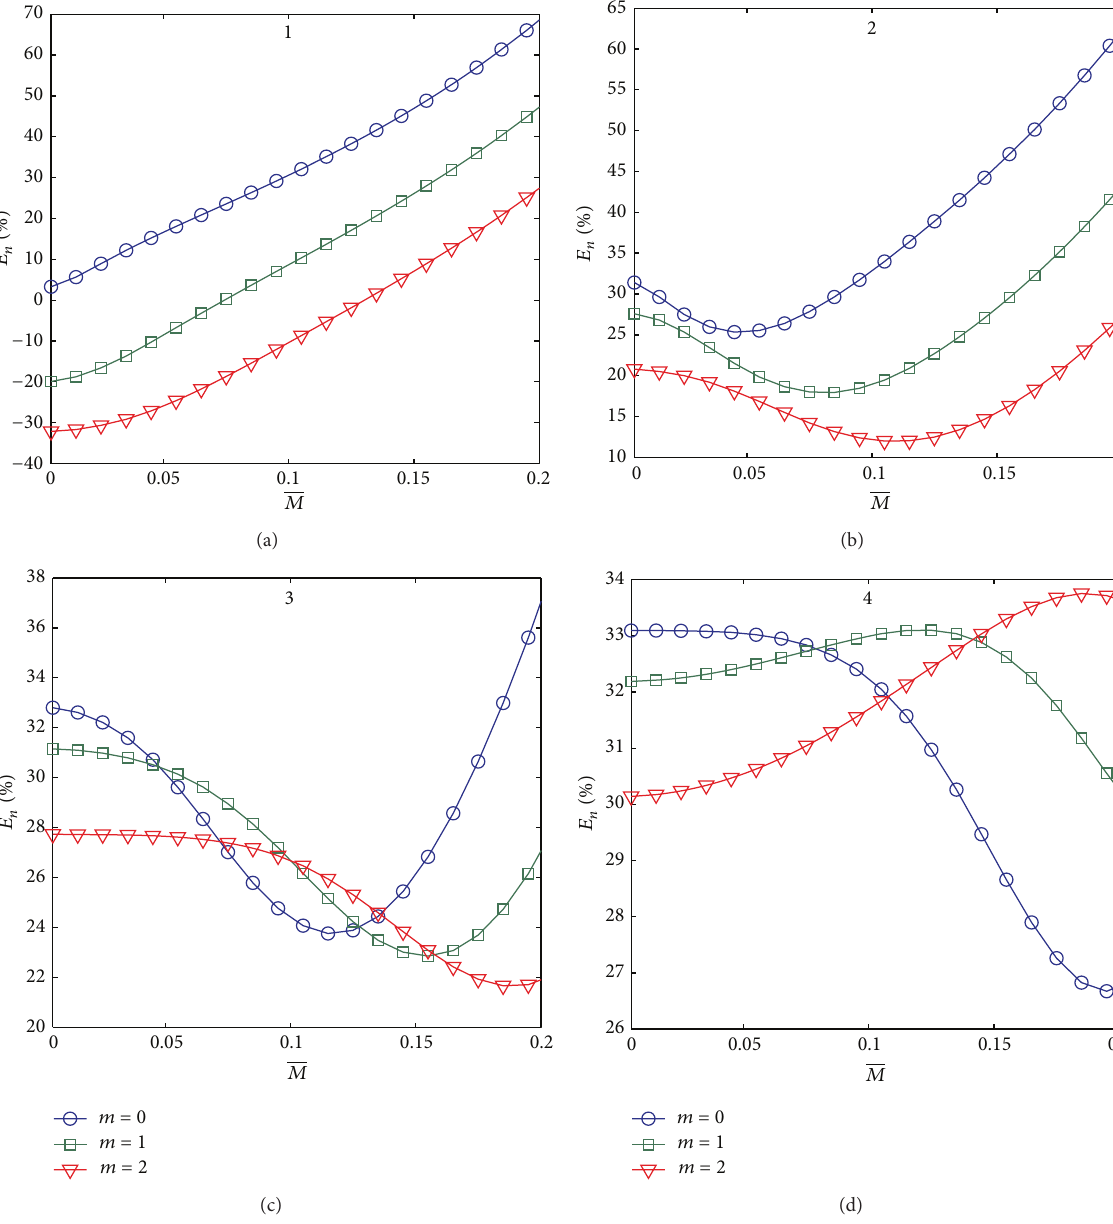
Figure 11: (Color online) Comparison of the measurement errors of the first four axial modes among the three circumferential modes ( 𝑚 = 0 , 𝑚 = 1 , and 𝑚 = 2 ) in the laminar flow confined by the lined-walled